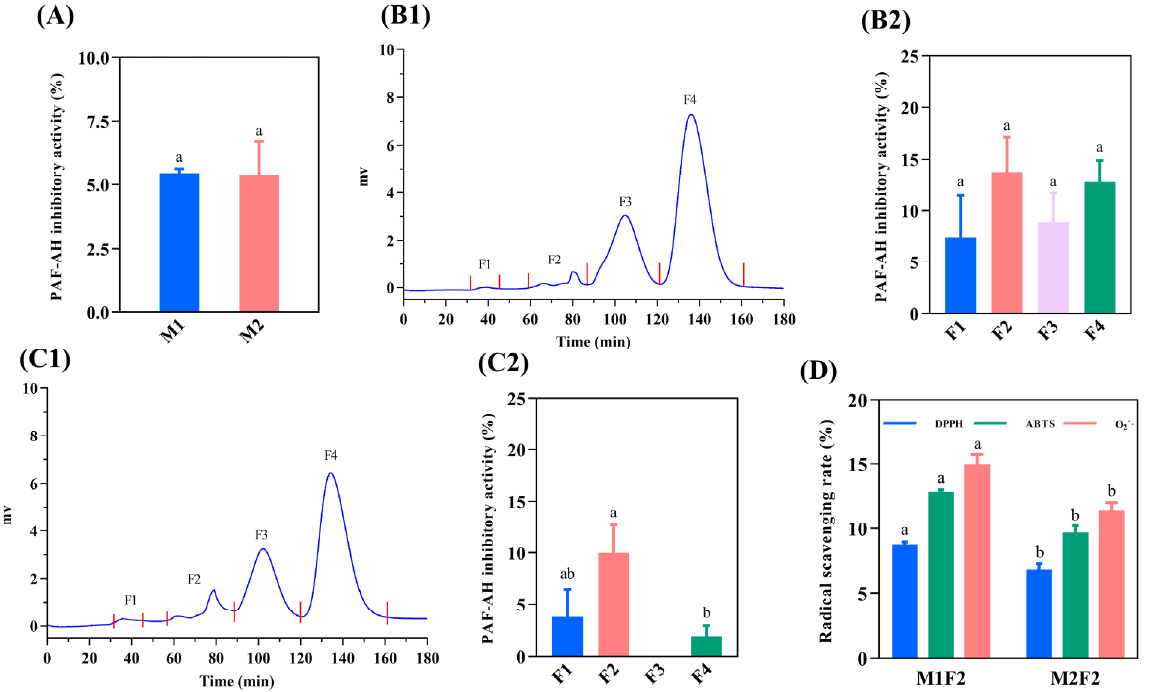
Figure 1. Isolation of peptides derived from dry-cured pork coppa by G-15 chromatography and function evaluation. The PAF-AH inhibitory activity of <3 KDa peptides ( A ). G-15 size-exclusion chromatography of peptides from M1 ( B1 ) and M2 ( C1 ). The PAF-AH inhibitory activity of purified fractions from M1 ( B2 ) and M2 ( C2 ). The radical scavenging activity of F2 fractions ( D ). The function evaluation was performed under a peptide concentration of 5 mg/mL. ( B2 , C2 ): Different lowercase letters indicate a significant difference, p < 0.05. ( D ): Different lowercase letters indicate a significant difference between M1F2 and M2F2, p < 0.05.